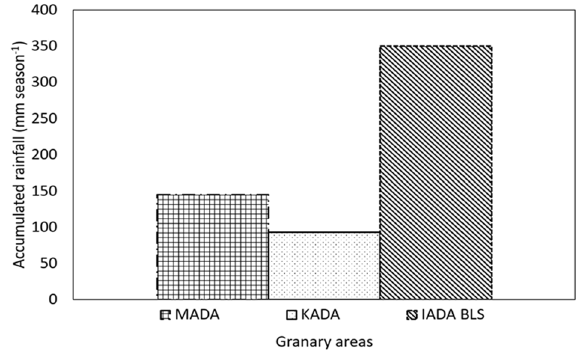
Figure 3. Accumulated rainfall recorded in different granaries. MADA: Muda Agricultural Development Authority, KADA: Kemubu Agricultural Development Authority and IADA BLS: Integrated Agriculture Development Area Barat Laut